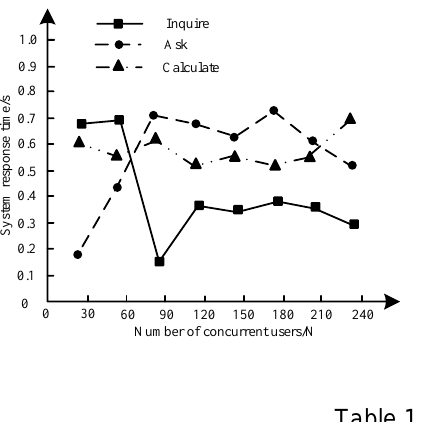
Table 1. System running test